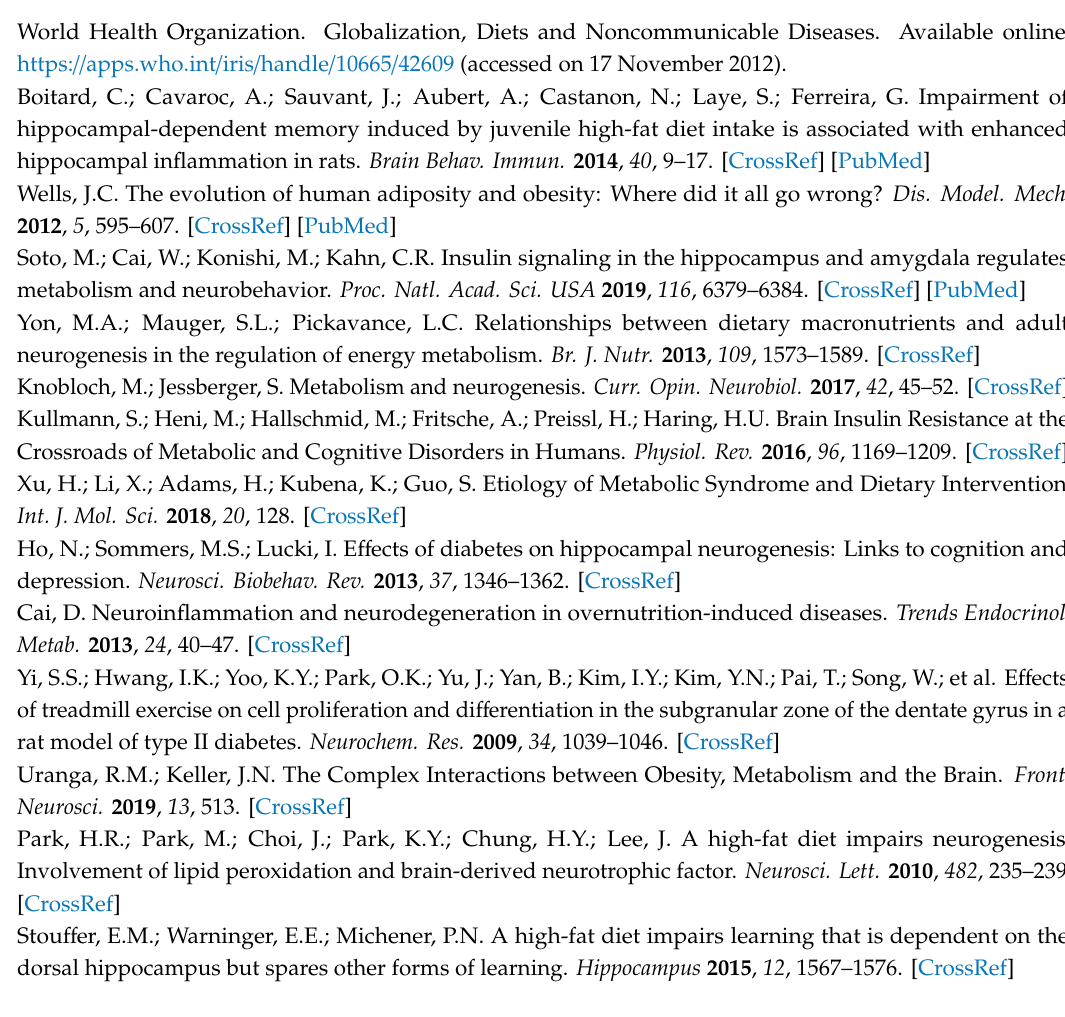
Figure S1: The expression of mitochondrial oxidative phosphorylation complex enzymes in fat tissues was comparable between Nox4 − / − and WT mice, Figure S2: The levels of Cystatin C, FGF-1 and IL-28B in the hippocampus from Nox4 − / − and WT mice, Table S1: Mean pixel density of